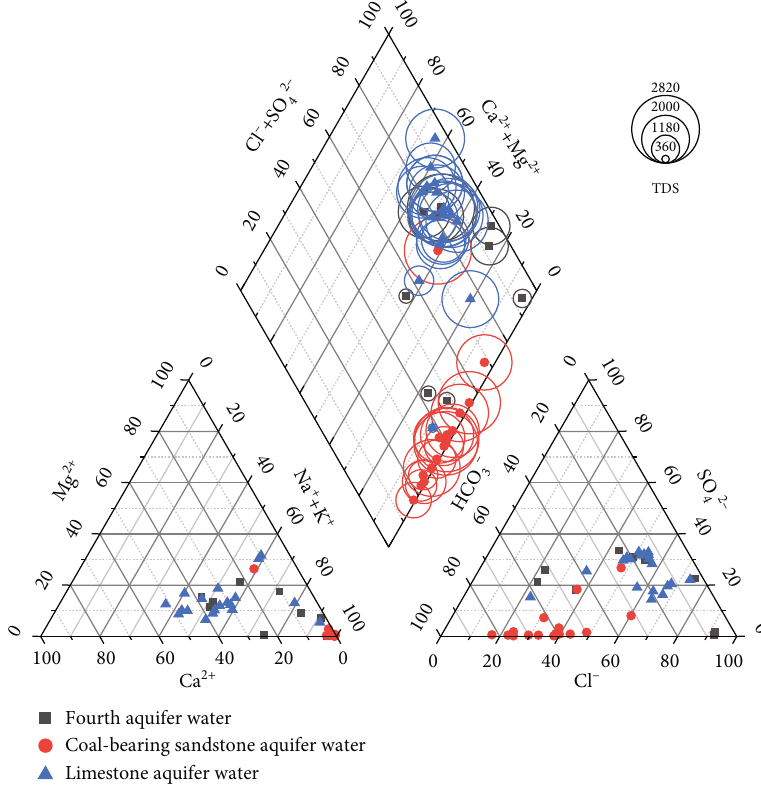
Figure 2: Piper trilinear diagram of the water samples from di ff erent water